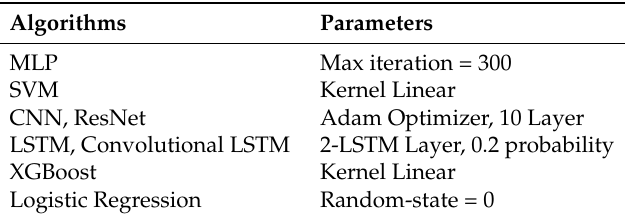
Table 2. Summary of